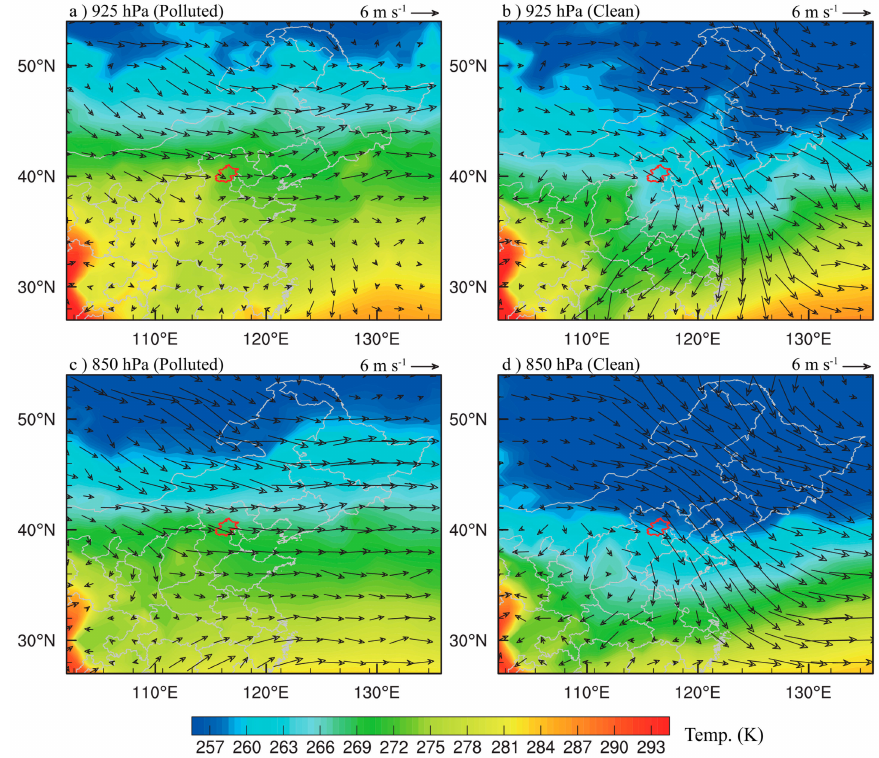
Figure 3. Spatial distribution of the wind field (black arrows, vector), superimposed by temperature (shaded) at 925 hPa ( a , b ) and 850 hPa ( c , d ) pressure level under polluted (left column) and clean (right column) conditions, respectively. All data are from the National Center for Environmental Prediction (NCEP) global Final (FNL) reanalysis. The areas highlighted with red lines represent the region of interest (Beijing), which is the same as the region highlighted with black lines in Figure